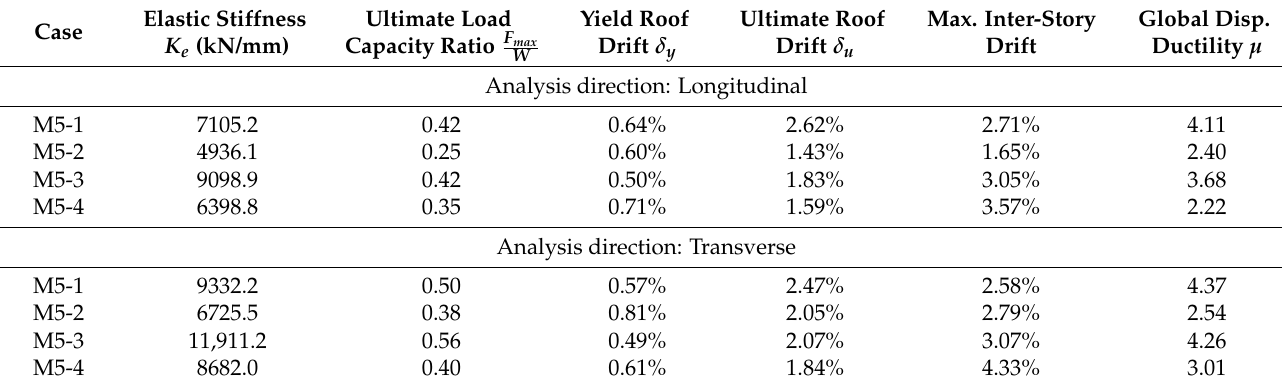
Table 5. Summary of the response parameters for the different cases of the M5